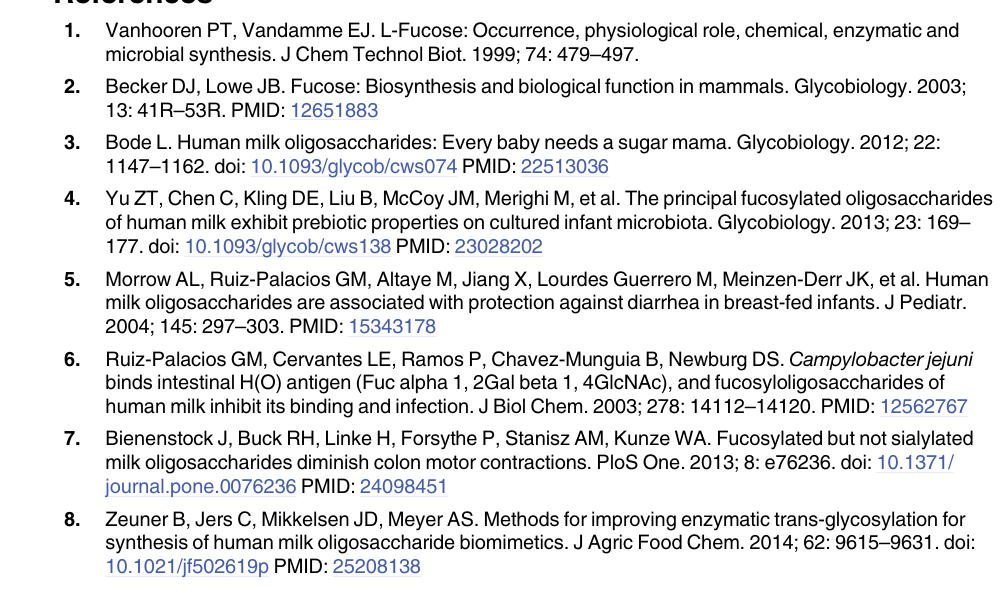
S1 Table. List of primers used for amplification of α -L-fucosidase-encoding genes. (PDF) S2 Table. Substrate specificity of characterized GH29 fucosidases.